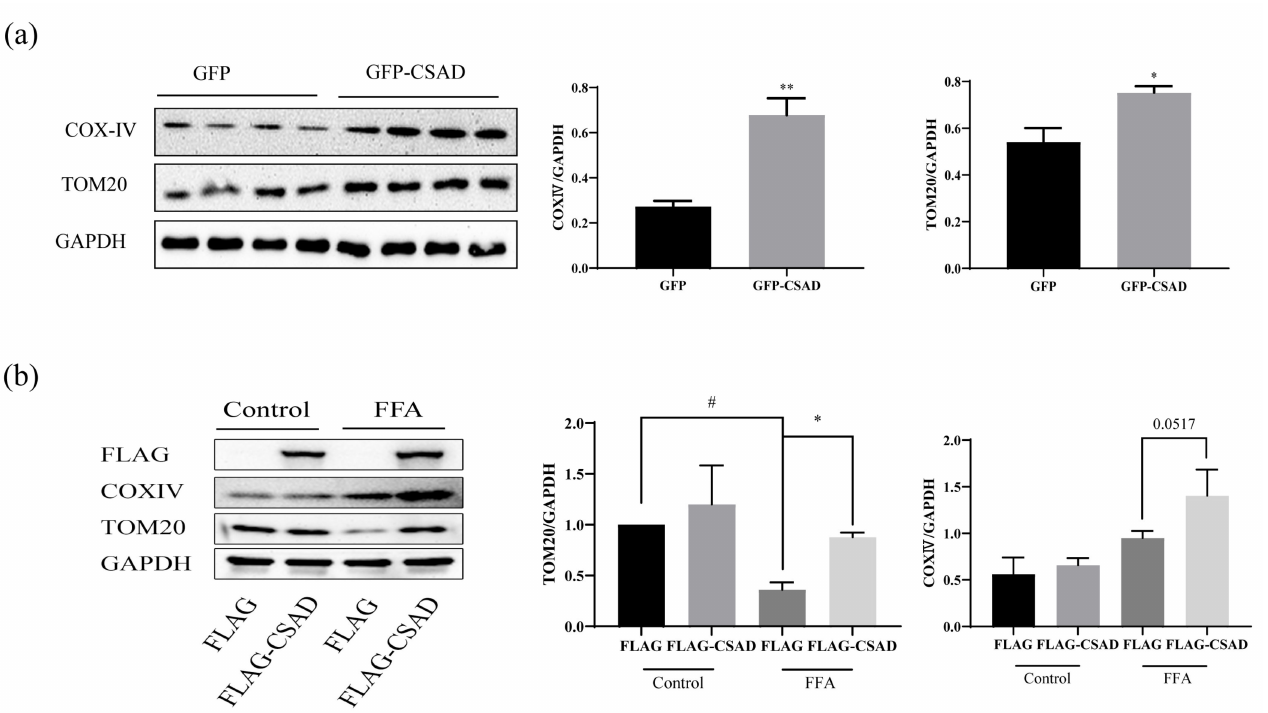
Figure 4. Overexpression of CSAD can attenuate mitochondrial damage in vivo and in vitro. ( a ) The levels of COX-IV and TOM20 in the liver. Fourteen weeks post-injection of AAV, the mice were sacrificed and the levels of COX-IV and TOM20 in the liver were detected by Western blot. In addition, the quantitative analysis used GAPDH as a normalizer; * p < 0.05, ** p < 0.01 vs. GFP group. ( b ) The levels of COX-IV and TOM20 in HepG2 cells. After being transfected with FLAG or FLAG-CSAD for 48 h, the HepG2 cells were incubated with or without 1mM FFA for 24 h, and the levels of TOM20 and COX-IV were detected by Western blot and quantitative analysis using GAPDH as the normalizer; # p < 0.001 vs. FLAG in the control group; * p < 0.01 vs. FLAG in FFA